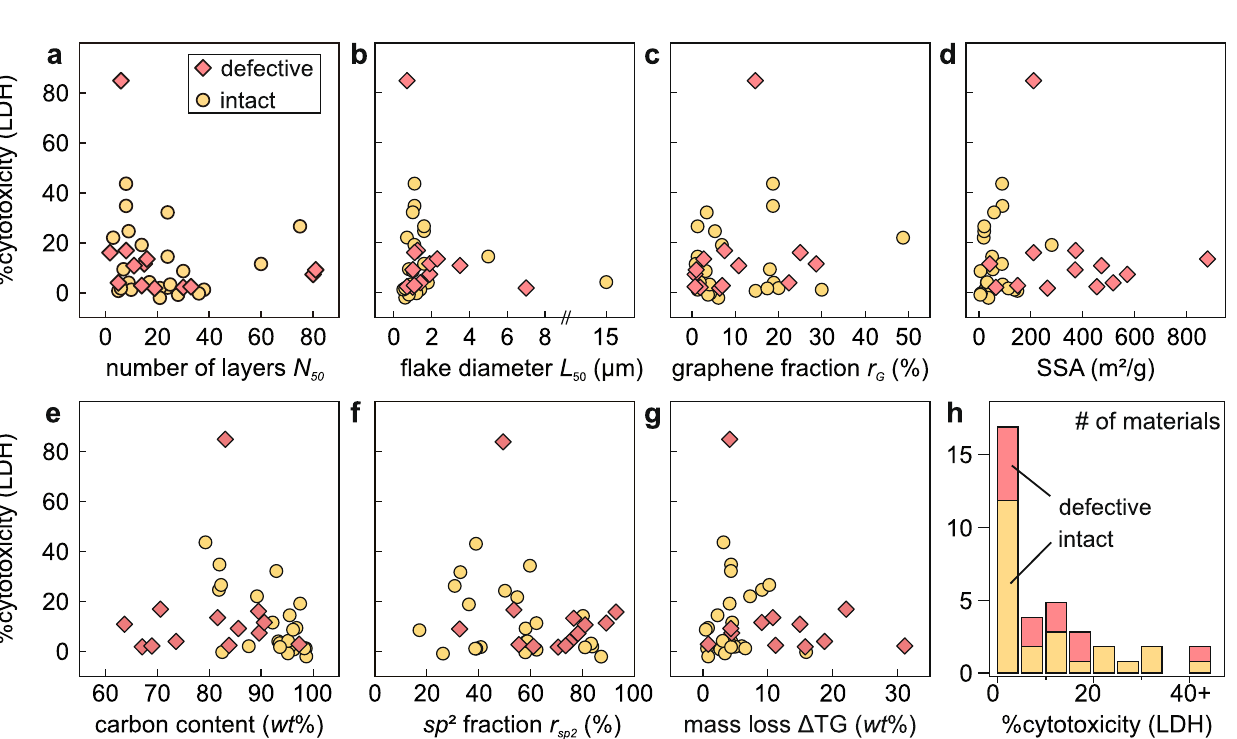
Fig. 3 Commercial graphene materials ’ properties induce varying %cytotoxicty responses in cells. Correlation analysis of %cytotoxicity (LDH release) stimulated by nominal graphene materials (NGM ’ s) at 10 µg/ml concentration: a Median of number of layers N 50 . b median fl ake diameter L 50 . c Graphene content r G . d Speci fi c surface area (SSA) calculated by the Brunauer, Emmett, and Teller method (BET). e Carbon content wt %( C ). f Fraction of sp 2 bounded carbon, r ( sp 2 ). g Thermogravitometric mass loss Δ TG in the 100 °C to 800 °C temperature range. h Representation of number of intact or defective NGMs to varying levels of %cytotoxicity. Intact graphene samples, NGM int , are represented by yellow circles and defective graphene samples, NGM def , are shown as red diamonds. The outlier (highest value measured in the Y axis) is shown only for reference and had not been included in the statistical analysis. The combined Spearman ’ s correlation ( r scom ) and the signi fi cance ( p -value) for each graph are presented in Table 1.